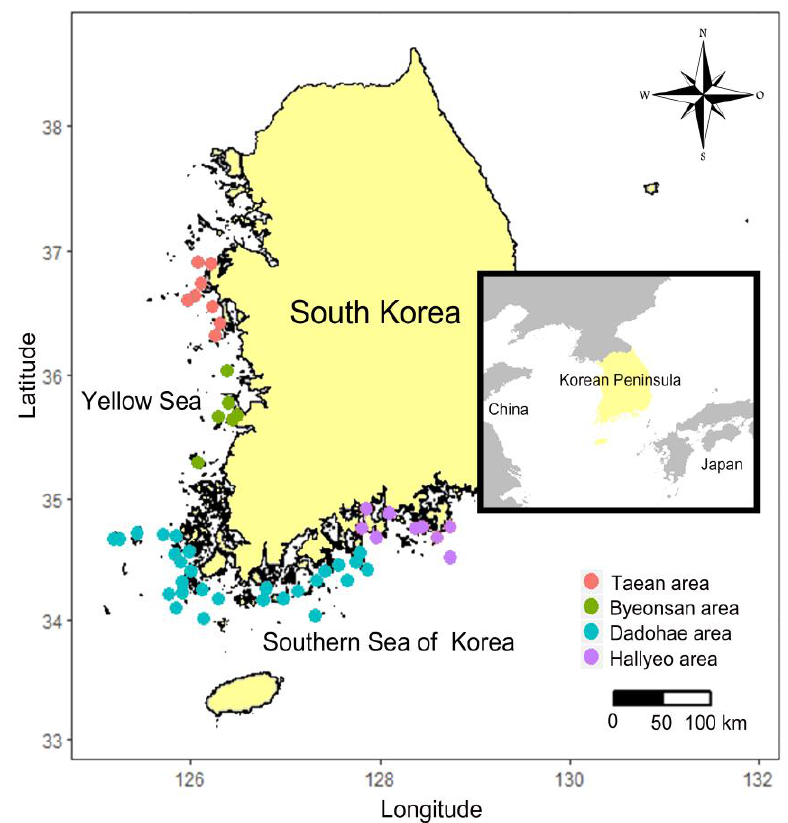
Figure 1. Sampling stations in the Marine and Coastal National Park areas of Korea.